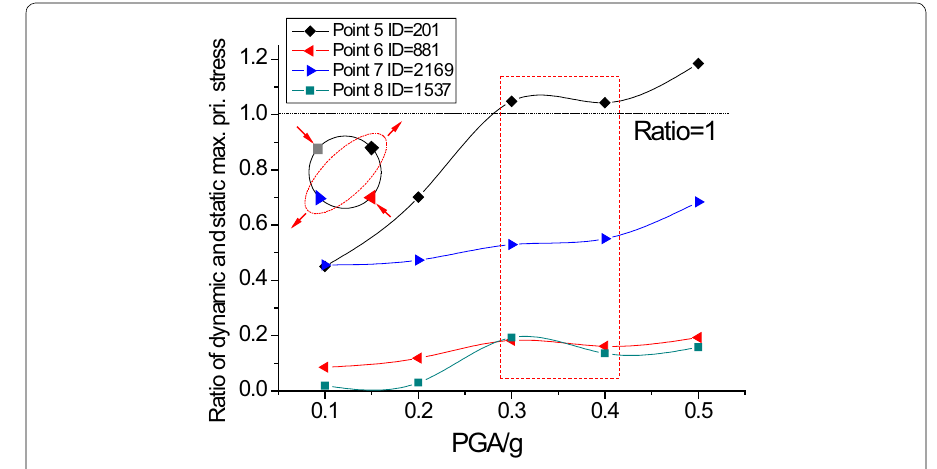
Fig. 11 Ratio of Max. Principle Stress of points